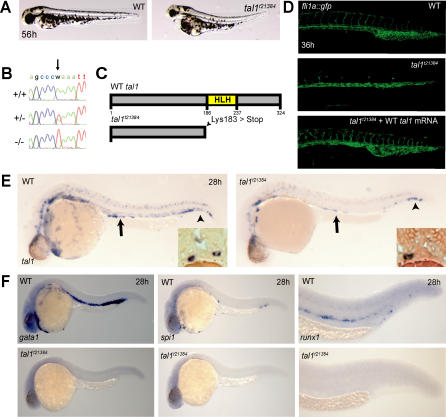
A Truncating Mutation in the Zebrafish tal1 Gene(A) Live micrographs of wt and tal1t21384 mutant embryos at 56h. Mutant embryos have slightly curved tails, smaller eyes, and pericardial edema.(B) Electropherograms of wt (+/+), heterozygous (+/−) and tal1t21384 homozygous genomic DNA from bp 7–17 of the third tal1 coding exon. The A→T transversion (arrow) mutates lysine 183 to an ochre (TAA) stop codon (K183X).(C) Schematic diagram of the primary Tal1 protein structure. The DNA-binding bHLH domain is indicated in yellow. The tal1t21384 mutation deletes the Tal1 protein C terminus including the complete helix-loop-helix domain(D) The tal1t21384 mutation leads to severe defects in intersomitic vessel formation at 36 hpf, visualized in a fli1a:gfp transgenic background. Early endothelial pattering can be rescued by injecting 20 pg wt tal1 mRNA into mutant embryos.(E) Loss of tal1 expression in tal1t21384 mutant embryos. In situ hybridization for tal1 shows a loss of tal1 expression in erythroid cells and a reduction of tal1 expression in the spinal chord. tal1 expression is retained at normal levels in some hematopoietic/endothelial progenitor cells in the tail (arrowheads) and in some mesenchymal cells of unknown nature just dorsal to the yolk extension (arrows). These bilateral cell populations lie ventral to the pronephric tubules and lateral to the gut endoderm (insets). Also note the loss of tal1 expression in the ventral wall of the dorsal aorta containing, in wt embryos, the definitive hematopoietic stem cells.(F) Loss of hematopoiesis in tal1t21384 mutant embryos. In situ hybridization for hematopoietic markers at 26 hpf shows a loss of primitive erythroid cells (gata1), primitive myeloid cells (pu.1), and definitive hematopoietic stem cells (runx1).